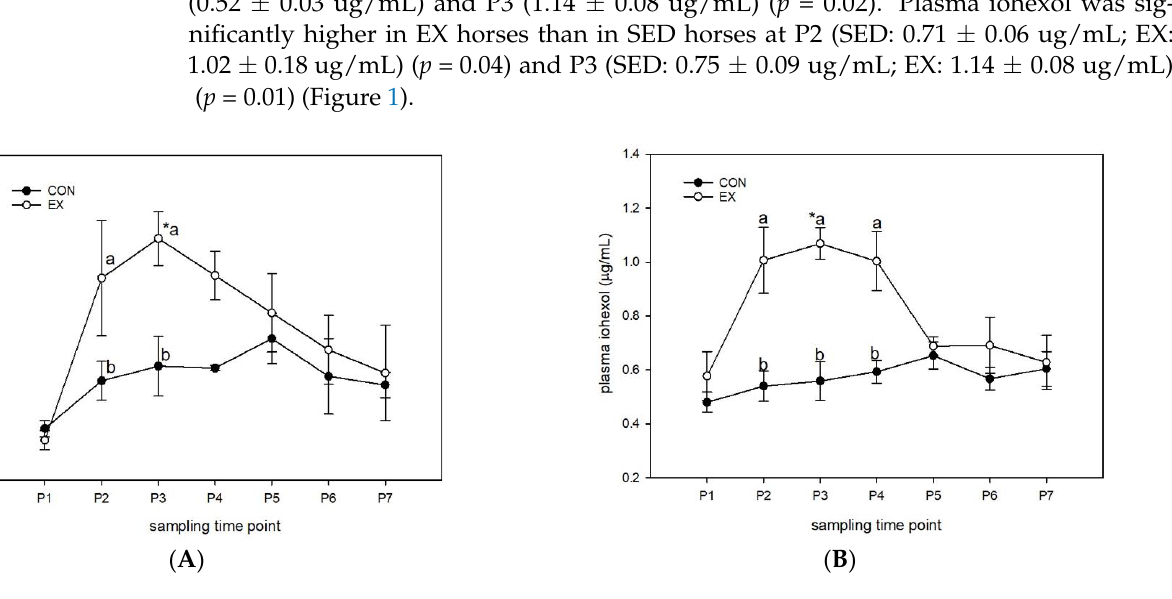
Figure 1. Plasma iohexol (µg/mL). Horses (n = 8) on the CO diet were administered an oral dose of iohexol (5.6% solution; 1 mL/kg BW) immediately prior to one hour of trailer transport followed by 30 min of moderate-intensity exercise (EX) on Day 0 (Panel ( A )) and Day 28 (Panel ( B )). Unchallenged horses (SED; n = 8) were maintained in stalls as controls and sampled at the same time intervals. Blood was sampled prior to iohexol administration (P1), immediately after trailering (P2), immediately after exercise (P3), and 1 (P4), 2 (P5), 4 (P6), and 8 h post-exercise (P7). * denotes significant change from baseline within a group; different letters denote significant differences between groups at a given time point.